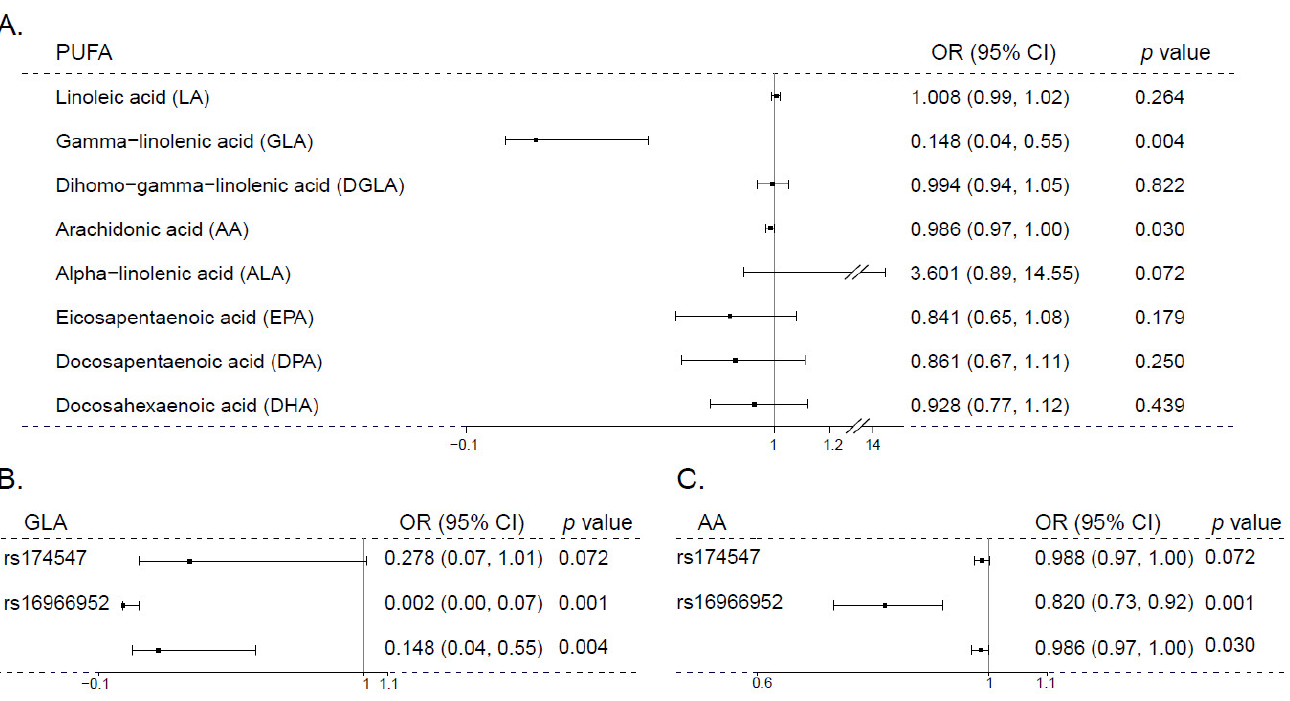
Figure 4. Associations of genetically predicted PUFA levels with schizophrenia. ( A ) This figure shows the Mendelian randomization inverse-variance-weighted (IVW) results for the relationship between the eight PUFAs and the risk for schizophrenia. ( B and C ) Forest plots of the individual SNP effects for genetically predicted GLA and AA levels on schizophrenia risk. These figures illustrate the contribution of individual instrumental variables used for the association between ( B ) GLA, ( C ) AA, and schizophrenia risk. PUFA—polyunsaturated fatty acid; OR—odds ratio per SD; and 95% CI—95% confidence interval. The middle line represents the null (OR = 1.000), and the error bars represent 95% CI.